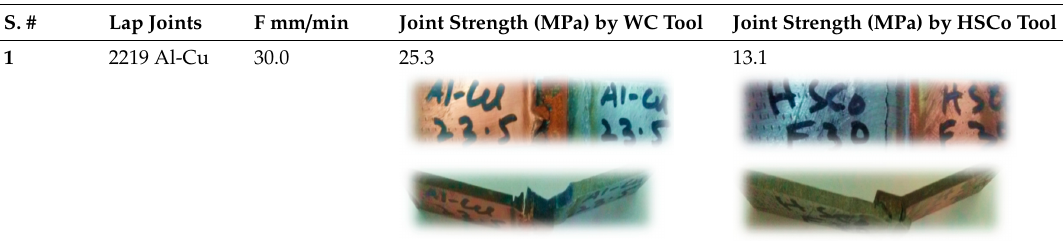
Figure 8. Dissimilar 2219 Al-Cu lap joints fabricated employing different tool materials: ( a , b , c , d ) WC square-pin tool at scale, ( e ) HSCo square-pin tool. Table 7. Comparison of joint strength between dissimilar lap joints fabricated with WC and HSCo-steel